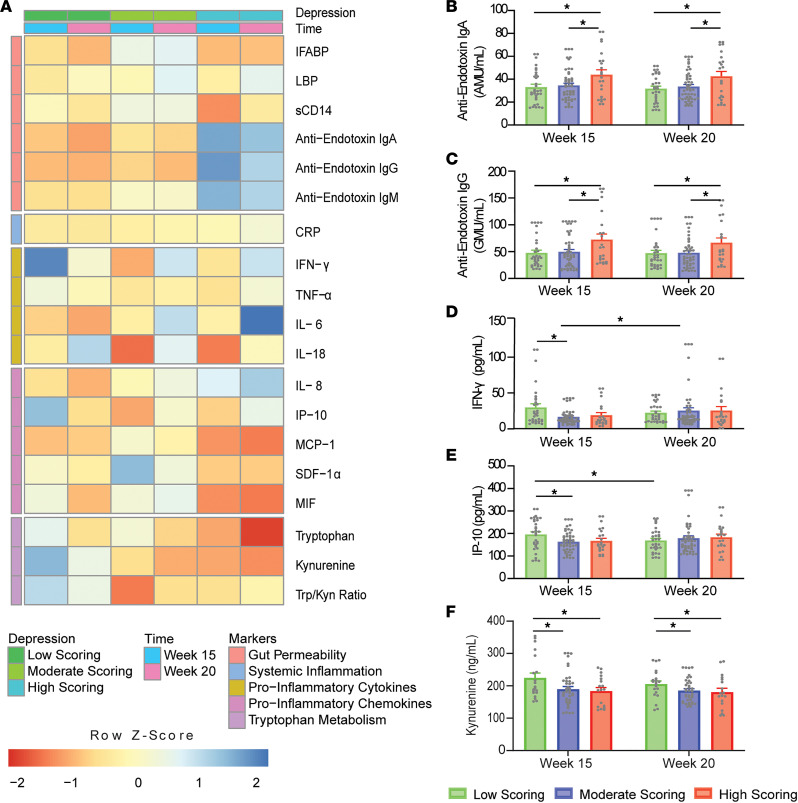
Differences in EPDS-scoring groups across gestational time points in the IBS cohort (N = 32/50/23 from low/moderate/high).(A) Heatmap of normalized biomarker means across scoring groups and time points. Individual boxes are represented on a scale from red to blue. Darker red boxes represent markers whose concentrations were found to be greater than 1 standard deviation lower than the mean concentration across stress group and time point. Darker blue boxes represent markers whose concentrations were found to be greater than 1 standard deviation higher than the mean concentration across stress group and time point. Lower z scores are evident for Trp in the high-scoring group at 20 weeks. Higher z scores are evident for IFN-γ in the low-scoring group at 15 weeks; for IL-6 in the high-scoring group at 20 weeks; and for anti-endotoxin IgA, IgG, and IgM in the high-scoring group at 15 and 20 weeks. Significant differences between EPDS-scoring groups are illustrated for (B) anti-endotoxin IgA, (C) anti-endotoxin IgG, (D) IFN-γ, (E) IP-10, and (F) Kyn (2-way ANOVA with Tukey’s HSD). *P < 0.05.